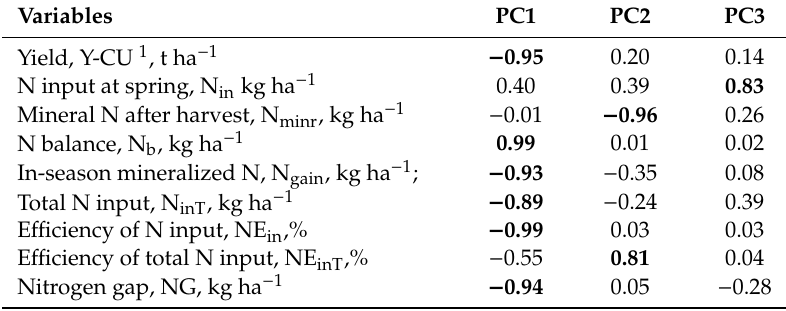
Table A2. Pearson’s correlation matrix between yield selected soil nitrogen variables and PCA factors for winter oilseed rape, n = 55.